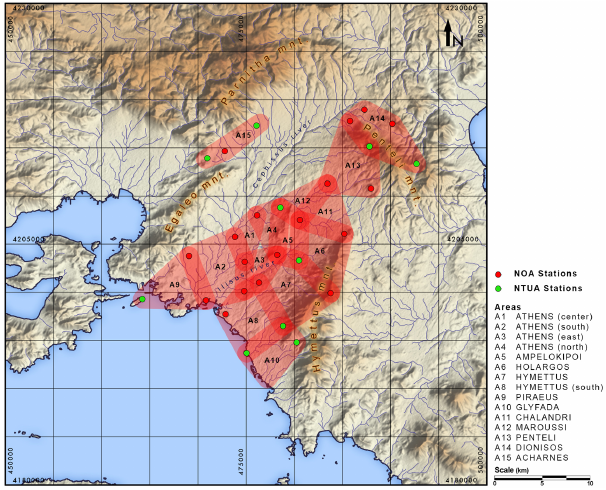
Figure 2. Division of Athens-suburbs region in 15 sub-areas. The representative rain gauges in each sub-area are also shown with red (NOA stations) and green (NTUA stations) bullets. (Created us- ing QGIS and SRTM-v3 elevation data. Projection GGRS87. Area easting: 450000–500000m. Area northing: 4180000–4230000m. Copyright NOA-IERSD.)